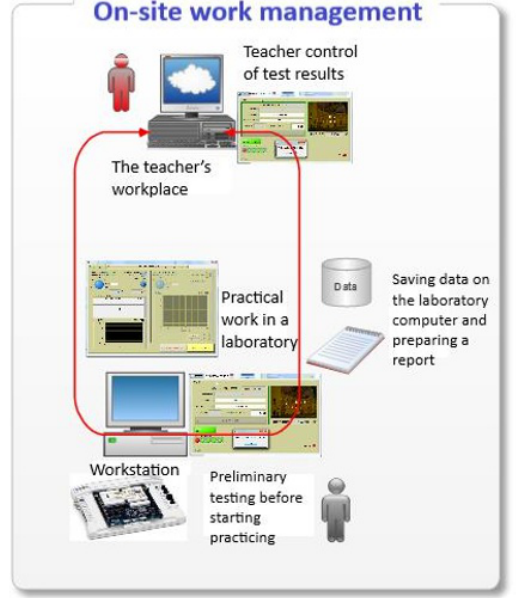
Fig. 3. On-site practical work management.